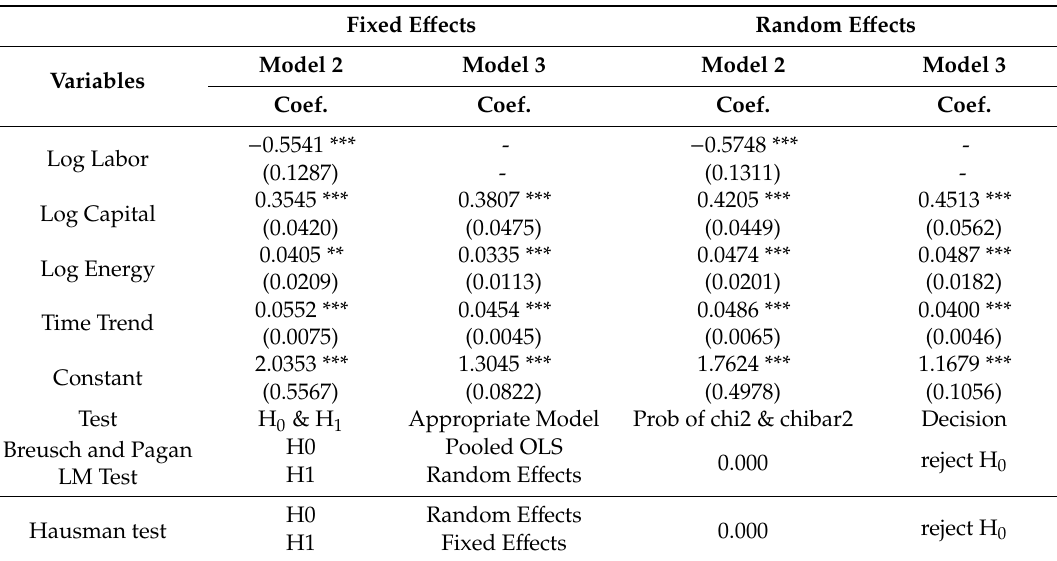
Table 5. Static panel estimation results for Models 2 and